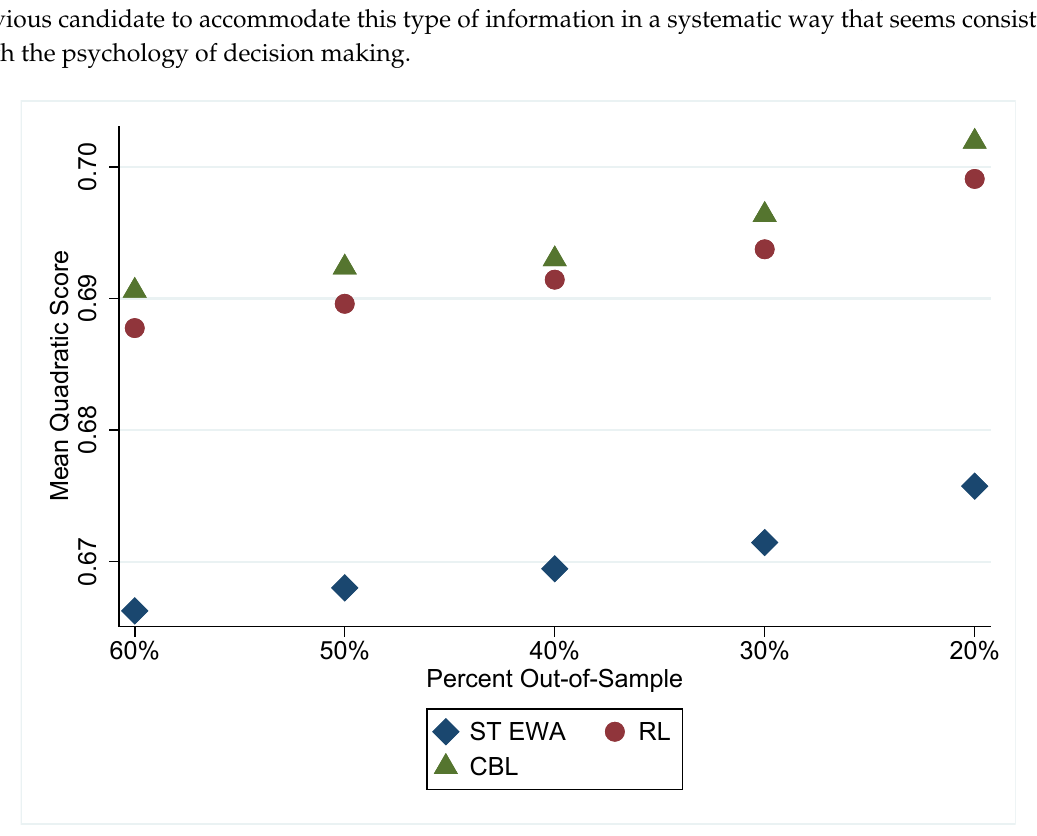
Figure 3. Out-of-sample Fit of Learning Models. Note: Each model is estimated using a portion of the data, while goodness of fit is measured on the remaining data. ST EWA refers to the self-tuning EWA, RL refers to reinforcement learning, and CBL refers to case-based